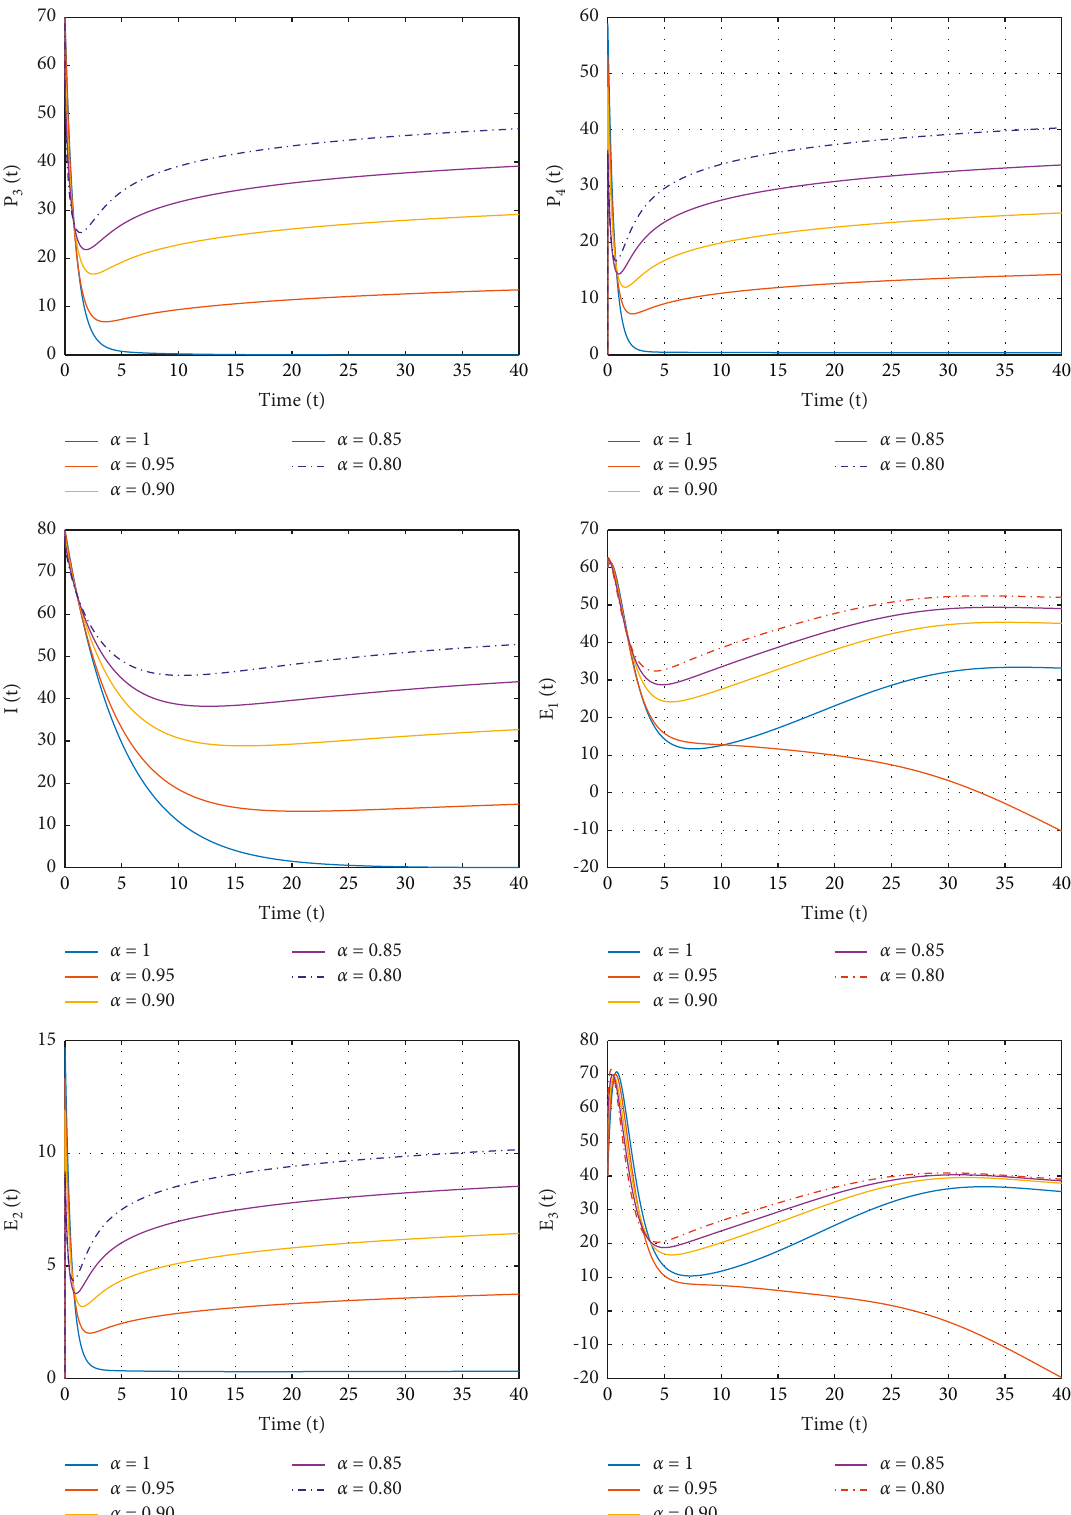
Figure 2: Fractional dynamics of reactants P